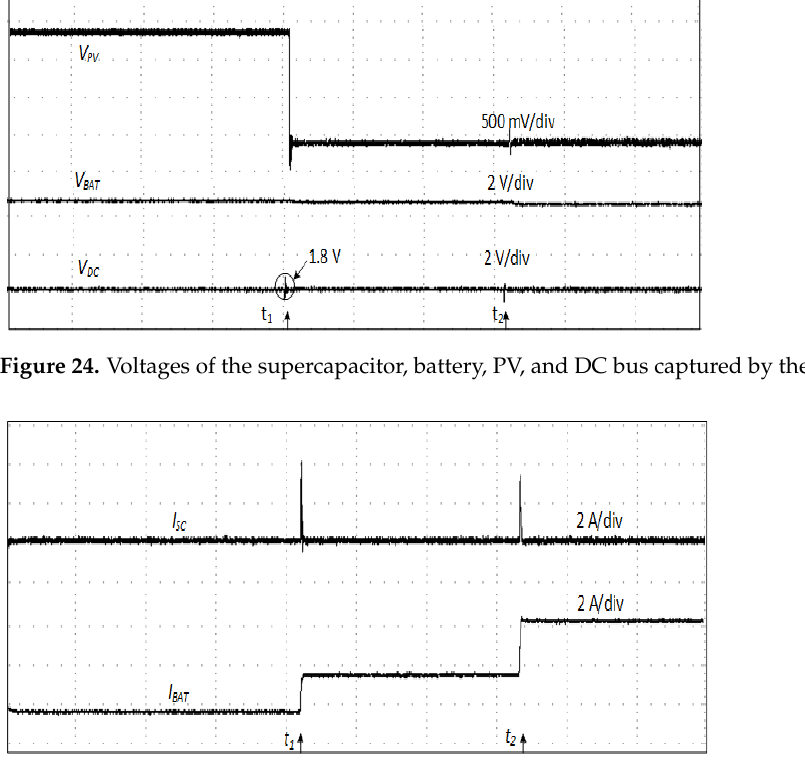
Figure 25. Supercapacitor and battery currents captured by the oscilloscope.